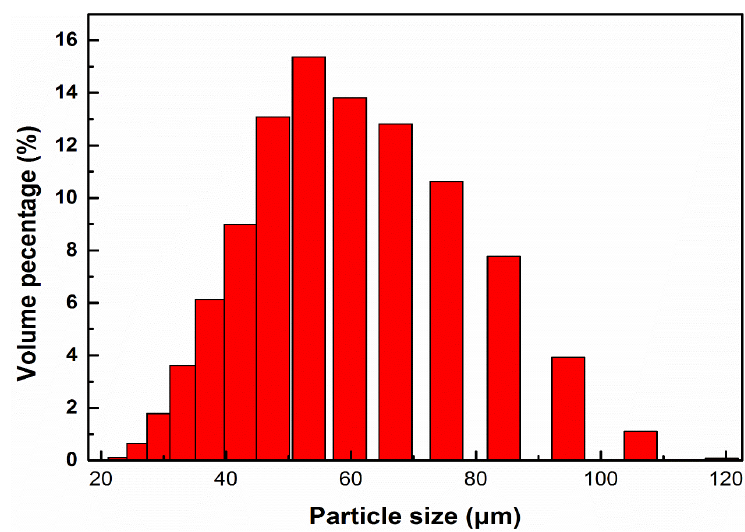
Figure 1. Size contribution of rutile sample.